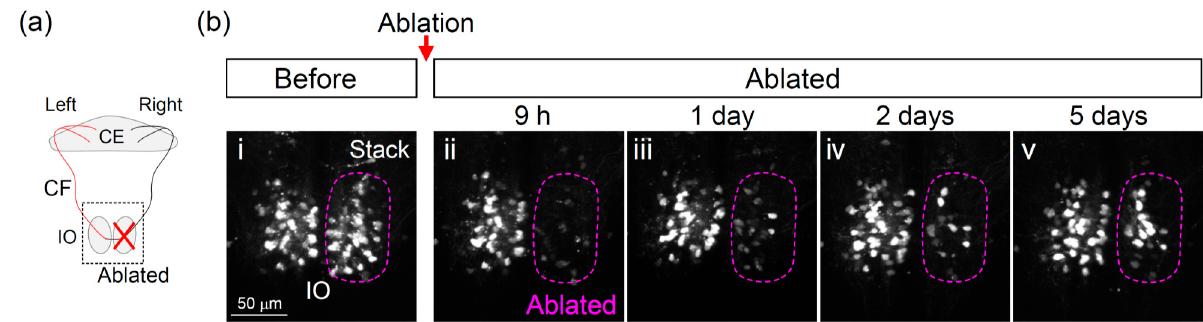
Figure 3. Changes in the inferior olive neurons after two-photon laser ablation: ( a ) Schematic diagram of the zebrafish inferior olive and cerebellum. CE: cerebellum, CF: climbing fiber, IO: inferior olive; ( b ) Dorsal view of the inferior olive (confocal z-stack images). The red dashed lines indicate the ablated region (the right hemisphere of the inferior olive). Before ablation: i, after ablation: ii (9 h), iii (1 day), iv (2 days), and v (5 days).